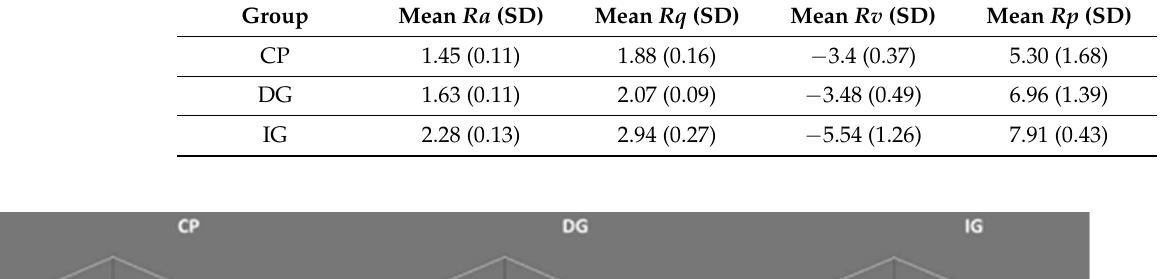
Table 6. The mean surface roughness values ( µ m) with standard deviation.